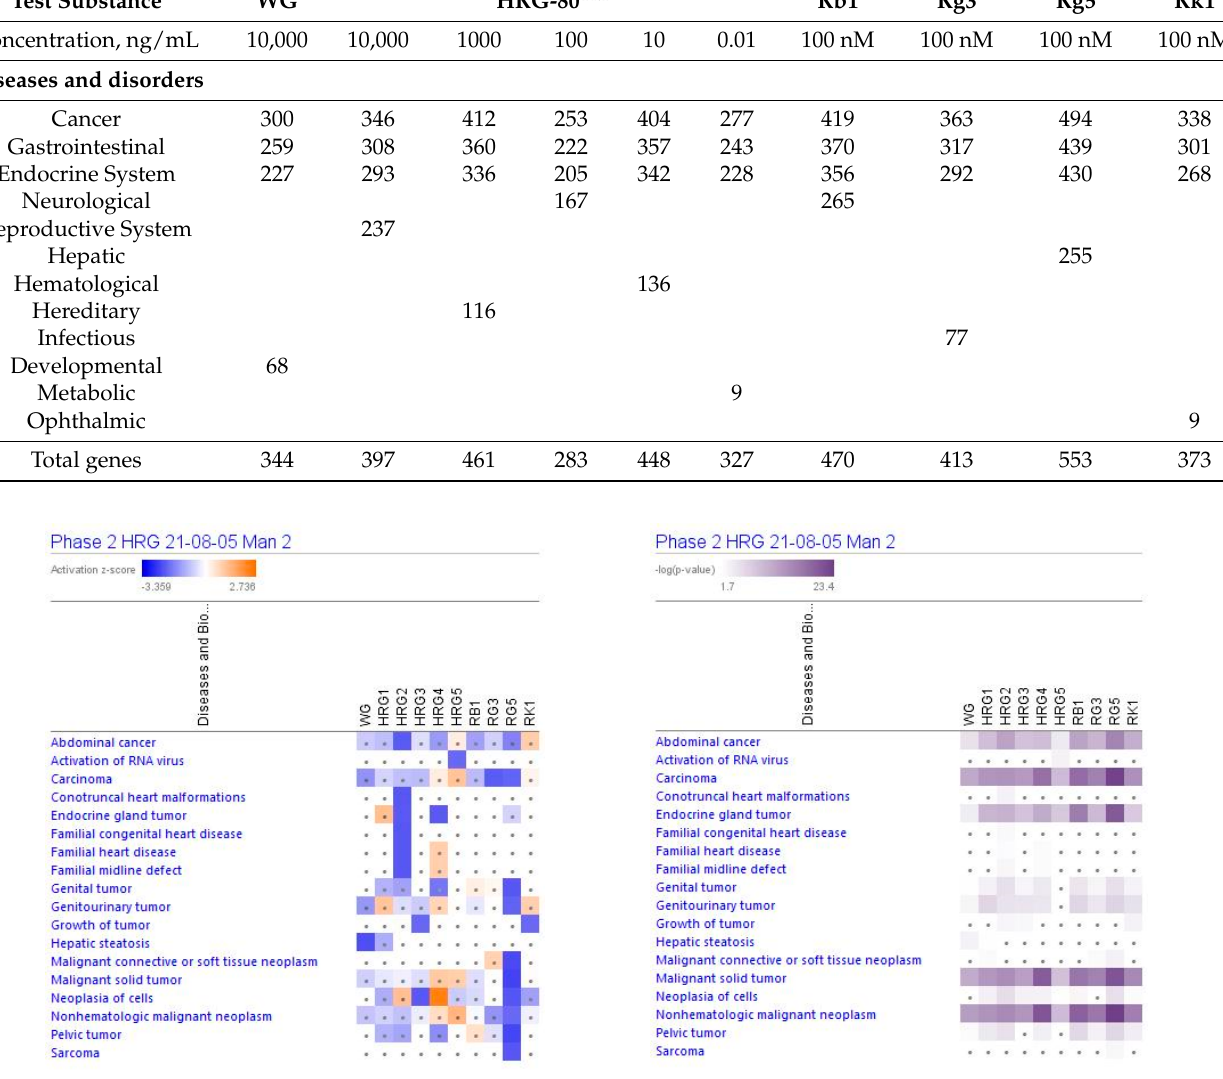
Figure 5. Effects of ginseng extracts WG (10 µ g/mL), HRG80 TM at concentrations of 10 µ g/mL (HRG1), 1 µ g/mL (HRG2), 100 ng/mL (HRG3), 10 ng/mL (HRG4), and 10 pg/mL (HRG5), and ginsenosides Rb1, Rg3, Rg5, Rk1 at a concentration 100 nM on diseases. Disease scores are presented using a gradient from dark blue to brown for predicted activation and light to dark blue for predicted inhibition of diseases; symbol · shows that the activation z-score was < 2 and a -log p -value < 1.3 = p < 0.05. An absolute z-score ≥ 2 is considered significant activation (+) or inhibition ( − ).